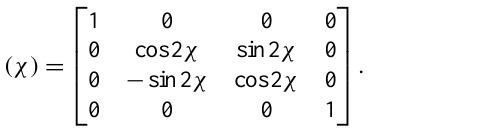
Figure 6. As in Fig. 5 but considering vertical polarization. sponse. This matrix is defined as (Liou,